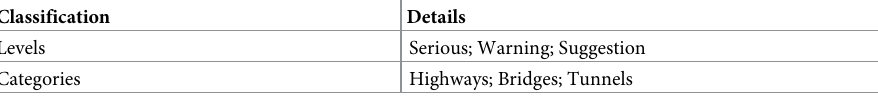
Table 2. The classification rules for the levels and categories of problems.